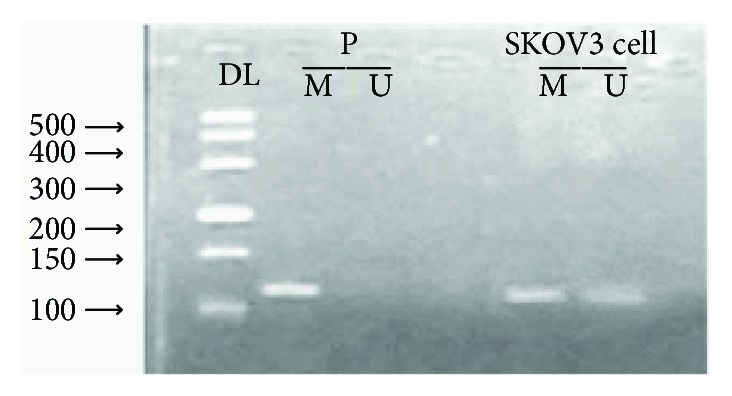
Methylation of Wnt5a in the human epithelial ovarian cancer cell line SKOV3. P: positive control; DL500: DNA marker; M: methylation; U: unmethylated.